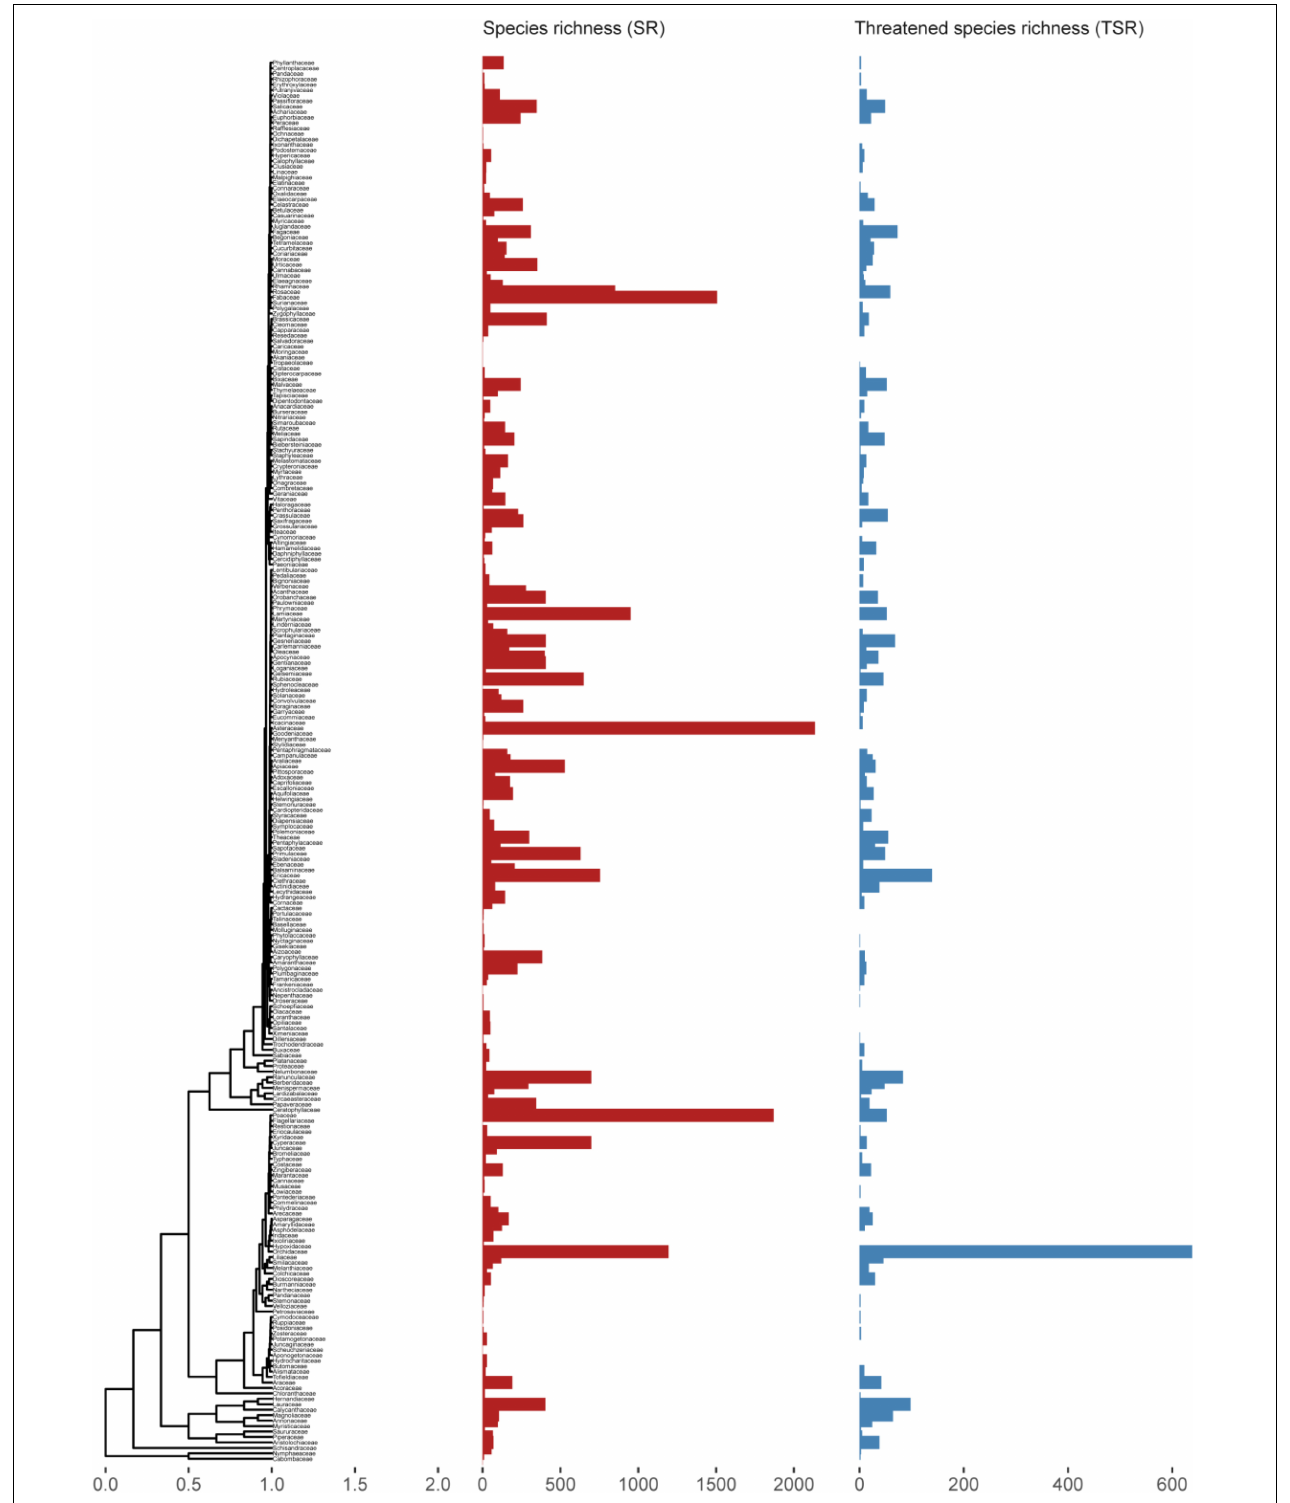
FIGURE 2 | Time-calibrated phylogeny of Chinese angiosperms families used in this study. Red bars represent genus species richness (GSR) in each family and blue bars represent threatened species richness (TSR) in each family.